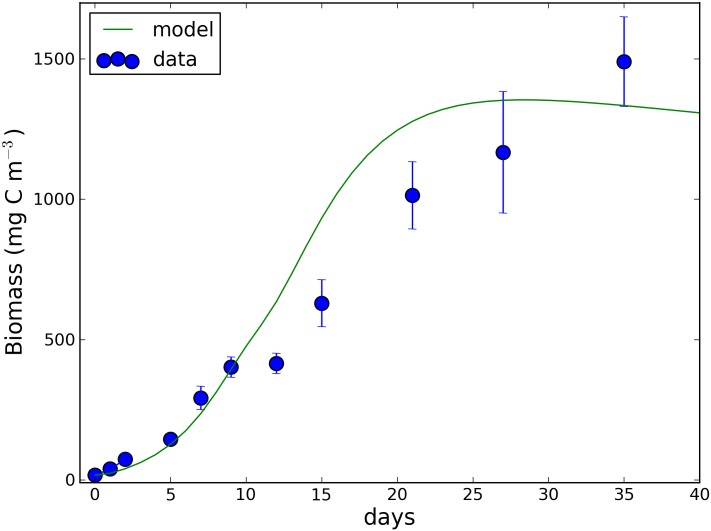
Observed and simulated bacteria biomass.